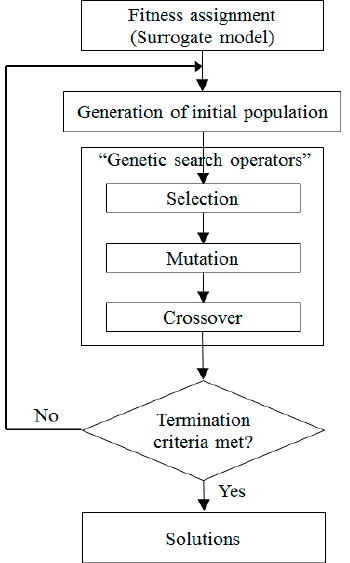
Figure 5. Genetic algorithm.